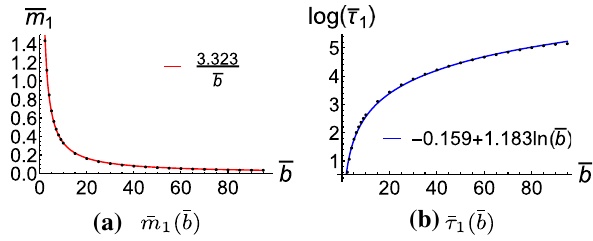
Fig. 3 The relations of the scaled mass ¯ m 1 and the scaled lifetime ¯ τ 1 of the first resonance with the parameter ¯ b for f ( T ) = T . The dots are calculated values while the red and blue lines are fit functions